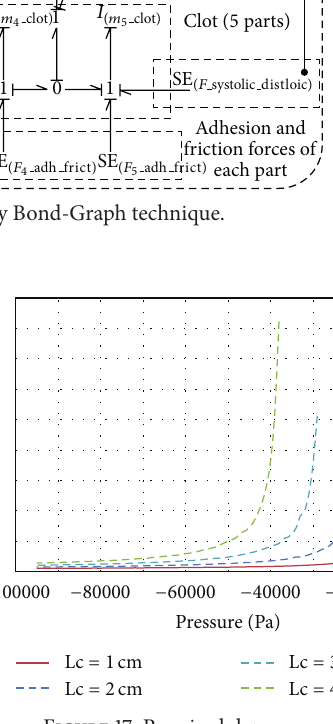
Figure 17: Required depressure versus